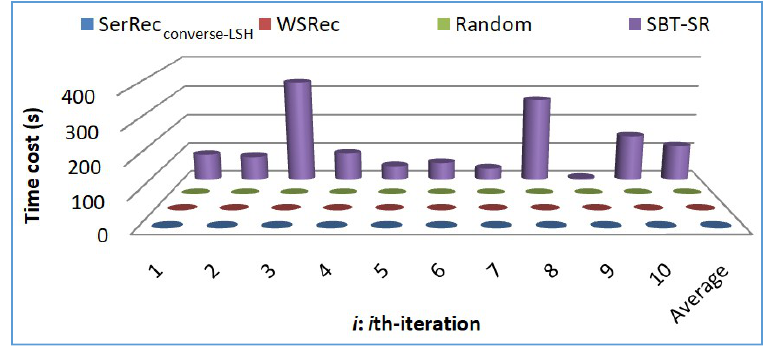
Figure 4. Recommendation efficiency comparison.